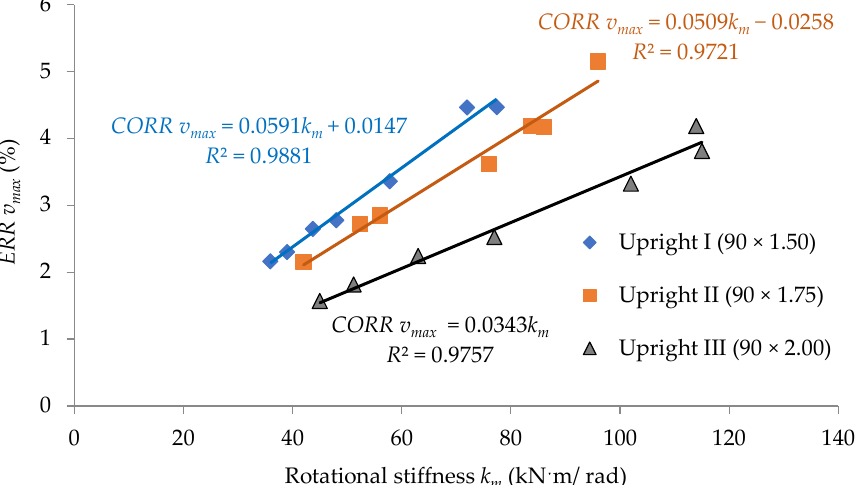
Figure 13. Variation of the calculation correction concerning the bending moment developed at midpoint of the beam related to the rotational stiffness k m of the connection for each type of the upright involved.